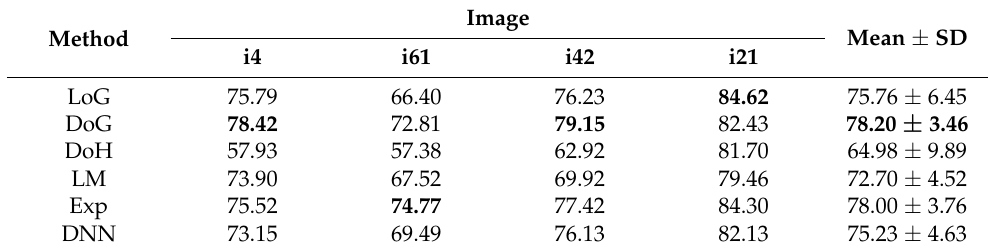
Table 1. Accuracy of methods for the optimal parameter